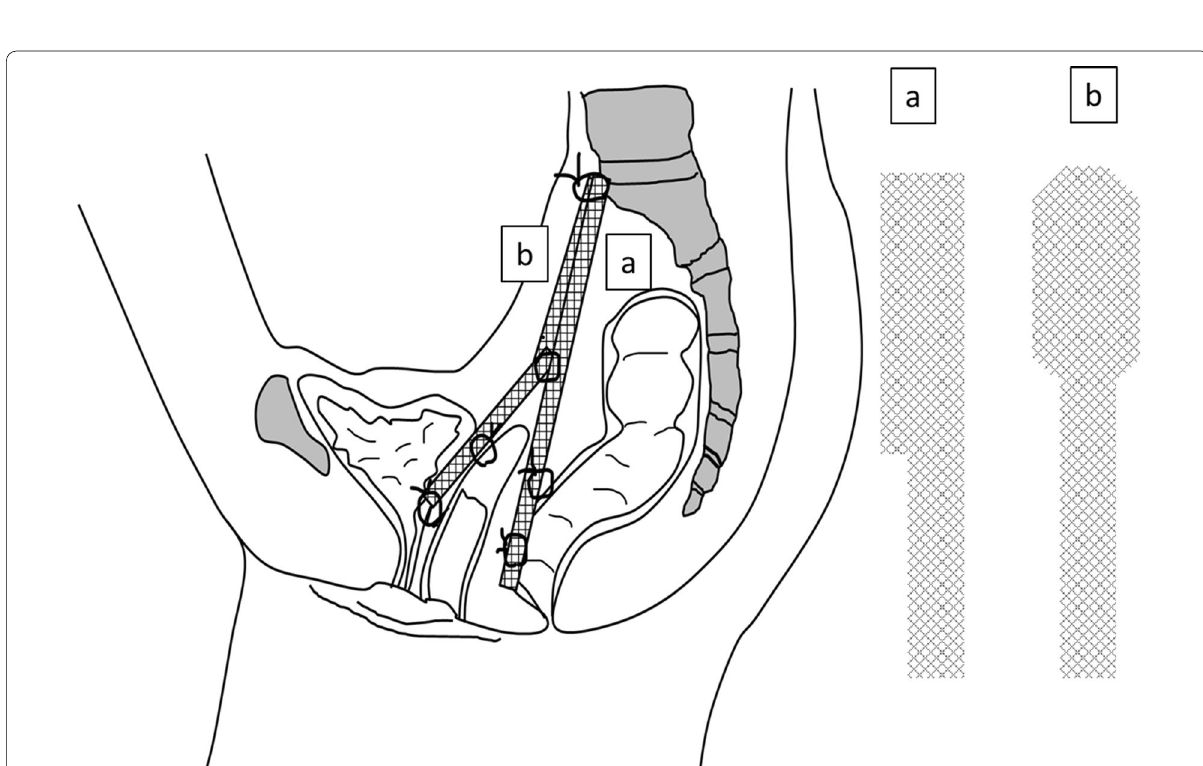
Fig. 4 The scheme of surgery. Mesh ( a ) and mesh ( b ) were used at rectovaginal space and vesicovaginal space,